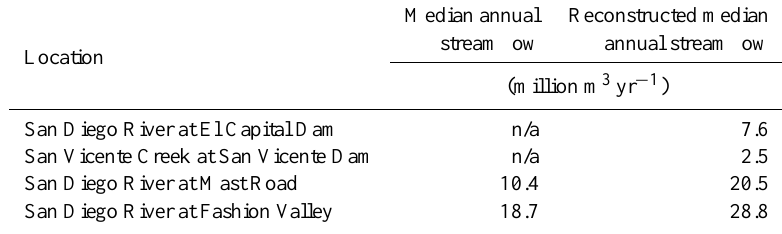
Table 6. Gaged and reconstructed streamflow in the San Diego River basin, San Diego region, California, for 1982–2009.